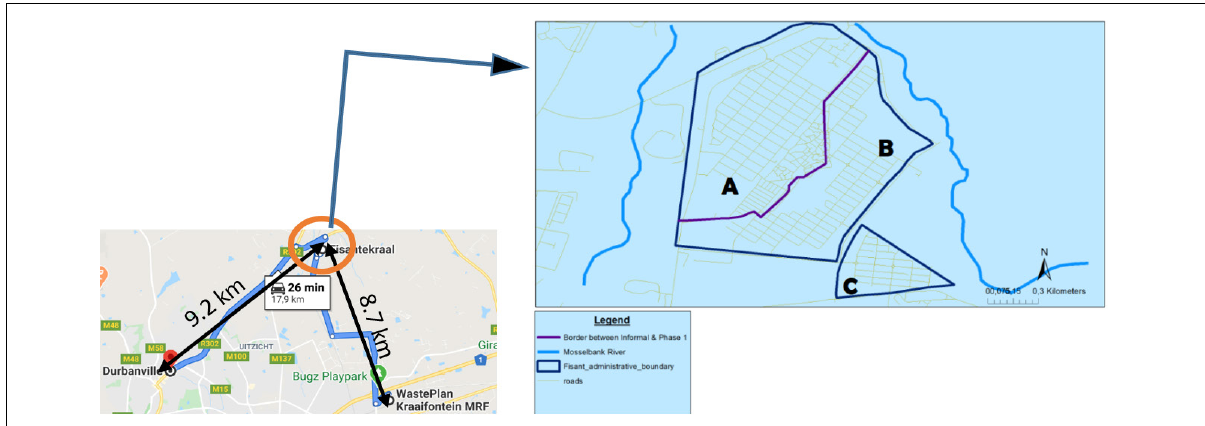
Figure 2: Fisantekraal